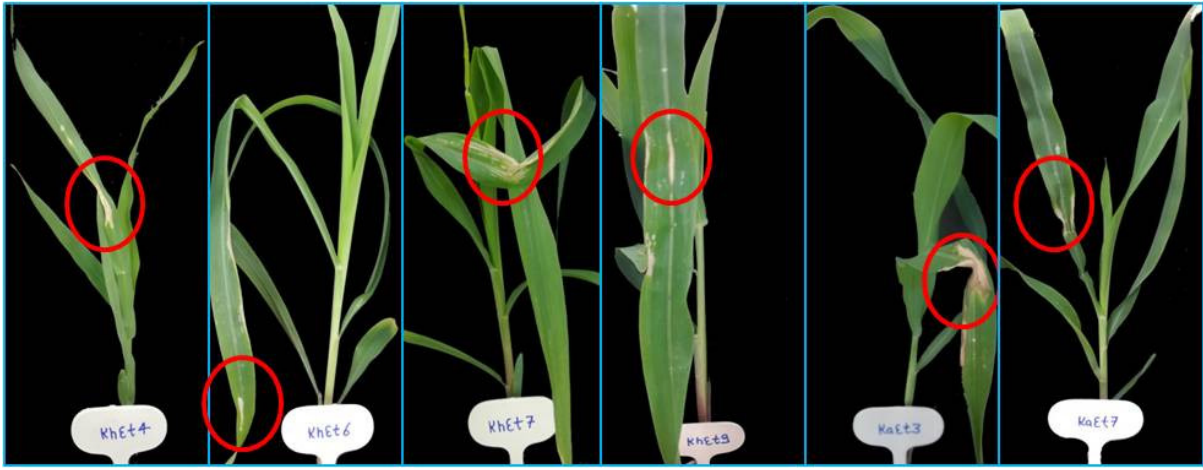
Bioengineering 2022 , 9 , x FOR PEER REVIEW Figure 1. Disease reaction of E. turcicum race 23N on differential line ‘55′ after 14th days of inocu- Figure 1. Disease reaction of E. turcicum race 23N on differential line ‘55 (cid:48) after 14th days of inoculation. lation.